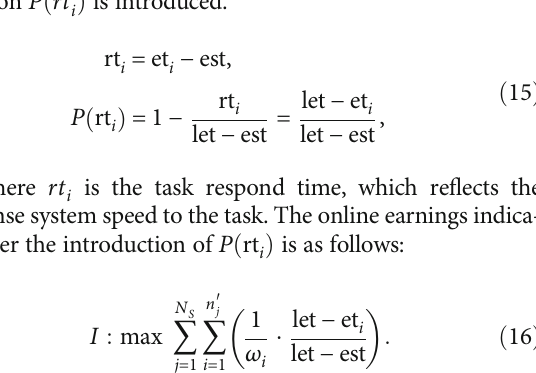
Figure 8: Observation model of swarm potential target search mission.